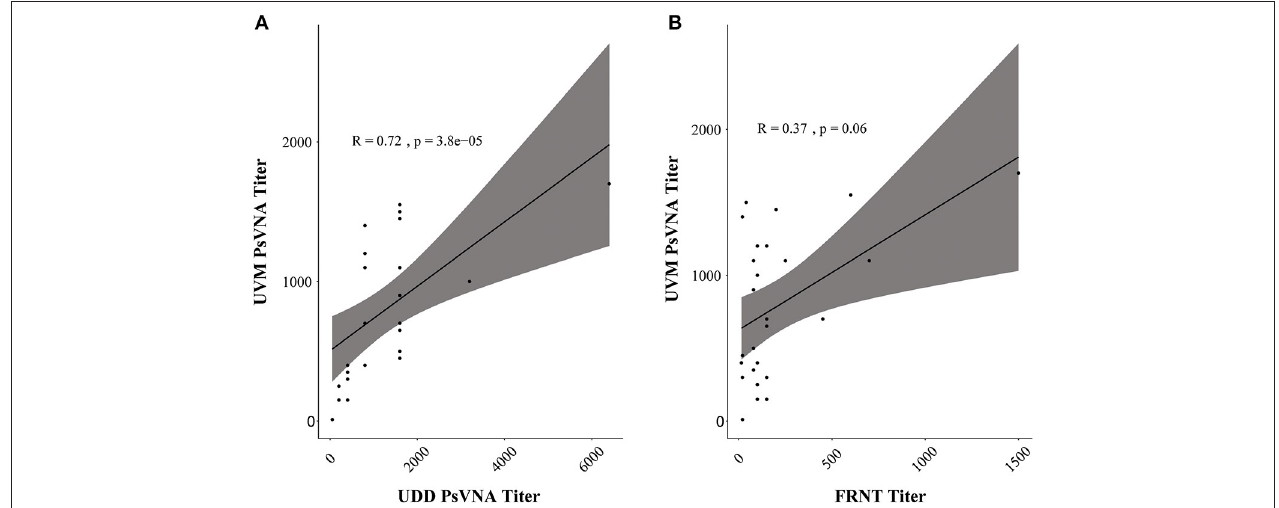
FIGURE 2 | Pseudovirion neutralization assay (PsVNA) titer measurement correlation. (A) Spearman correlation of neutralizing antibody (NAb) titer measured by vesicular stomatitis virus (VSV) 1 G/ Andes orthohantavirus (ANDV) glycoprotein (GP) luciferase assay (PsVNA) performed in Chile [Universidad del Desarrollo (UDD)] vs. replication-competent rVSV/ANDVGP plaque reduction neutralization test (PRNT) assay carried out in Vermont [University of Vermont (UVM)]. In gray is the confidence interval (95%). (B) Spearman correlation of NAb titer measured at UVM via replication-competent rVSV/ANDVGP PRNT vs. orthohantavirus focus reduction neutralization test (FRNT). In gray is the confidence interval (95%).